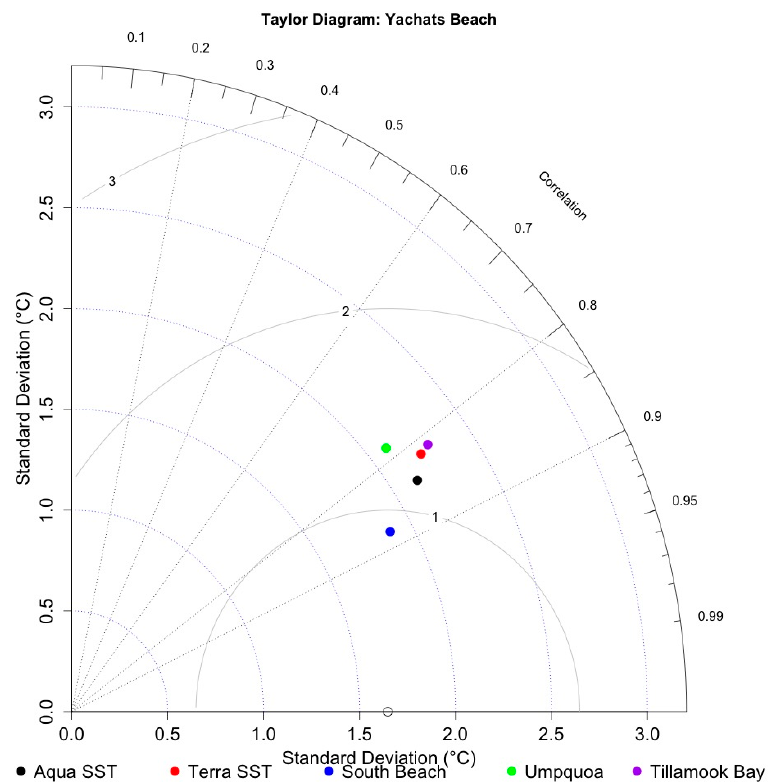
Figure 5. Taylor diagram for Yachats Beach where each water temperature estimate (Aqua SST, Terra SST, South Beach water temperature, Umpquoa Offshore water temperature, and Tillamook Bay water temperature) was used to predict daily submerged mussel logger temperature. South Beach water temperature was the best predictor of daily submerged mussel logger temperature when compared to the other water temperature estimates. The second-best predictor for logger temperature at Yachats Beach was Aqua SST.